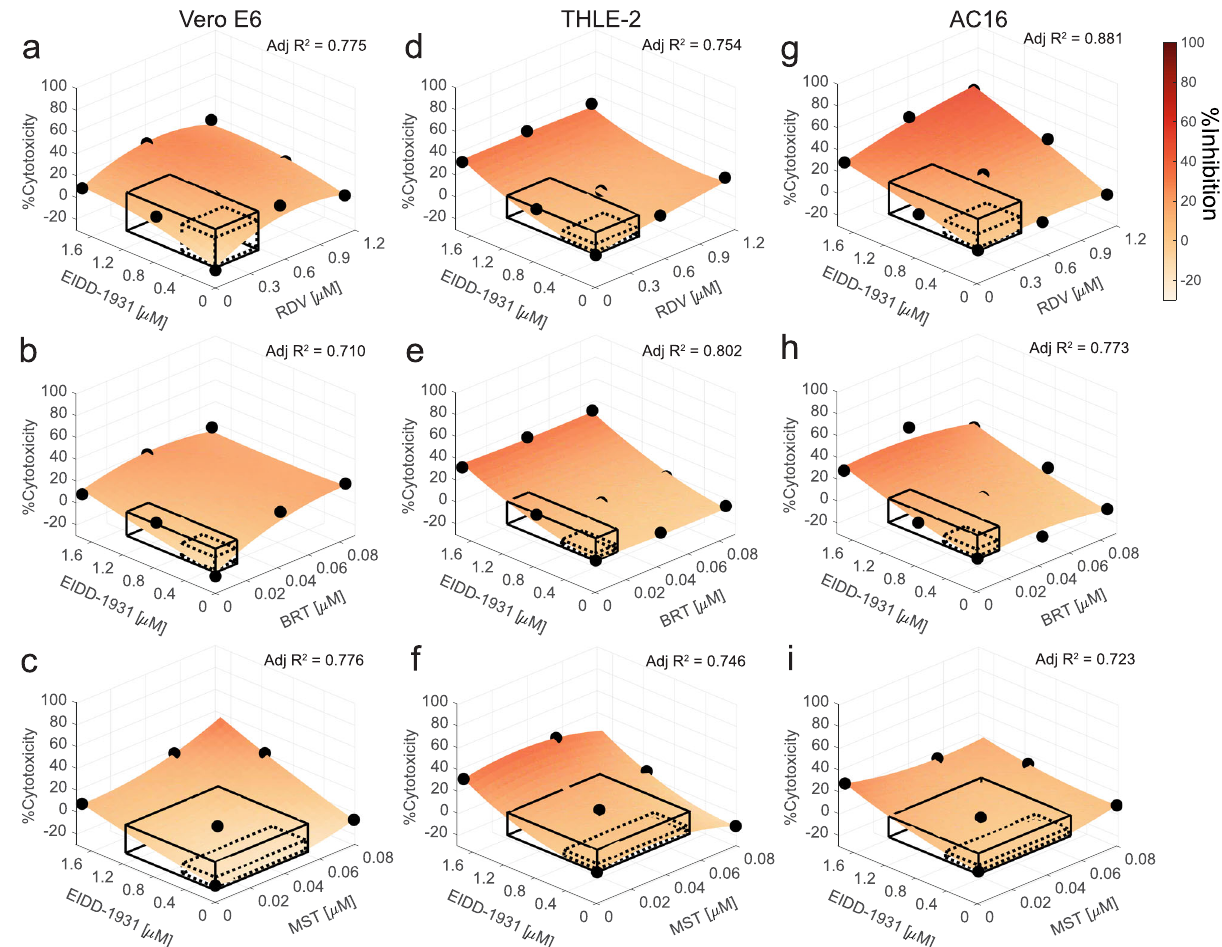
Fig. 5 Validation of EIDD-1931 drug interactions affecting %Cytotoxicity. Surface plots of EIDD-1931 interactions with remdesivir (RDV), baricitinib (BRT) and masitinib (MST), in the validation interaction space, clinically actionable interaction space (black, solid line border) and the interaction space from the IDentif.AI-x analysis (black, dotted line border), based on the experimentation in Vero E6 cells ( a – c ), THLE-2 ( d – f ) and AC16 ( g – i ). a – i All experiments were performed with N = 3 to 4 replicates, which were independently included in the surface construction. Black, round markers indicate an average %Cytotoxicity of the replicates for each data point. Adjusted R 2 (Adj R 2 ) indicates goodness of the fi t for each interaction